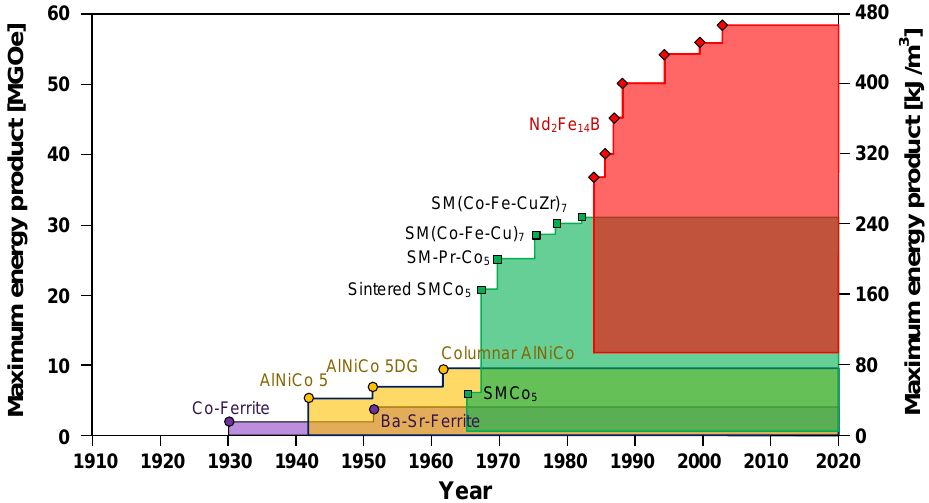
Figure 1. Evolution of PM materials over 100 years [2]. Table 1. Typical physical properties of common PM materials